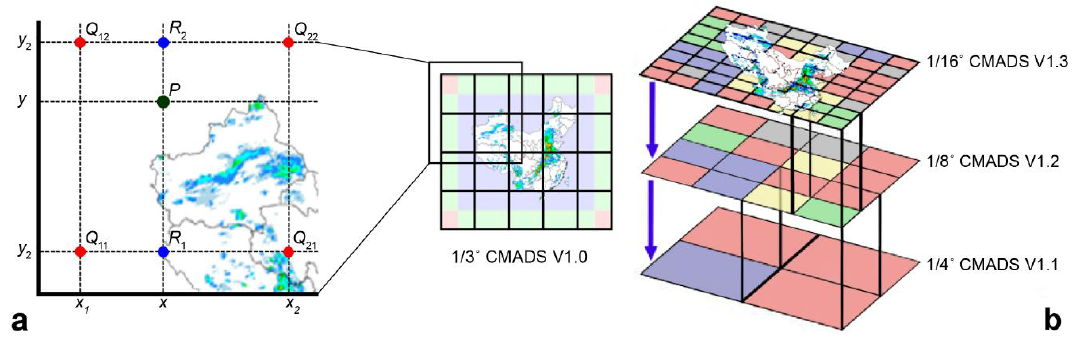
Figure 3. The interpolation methods used in CMADS. ( a ) Bilinear interpolation for CMADS V1.0, ( b ) Nested assignment for CMADSV1.0 to CMADS1.3.